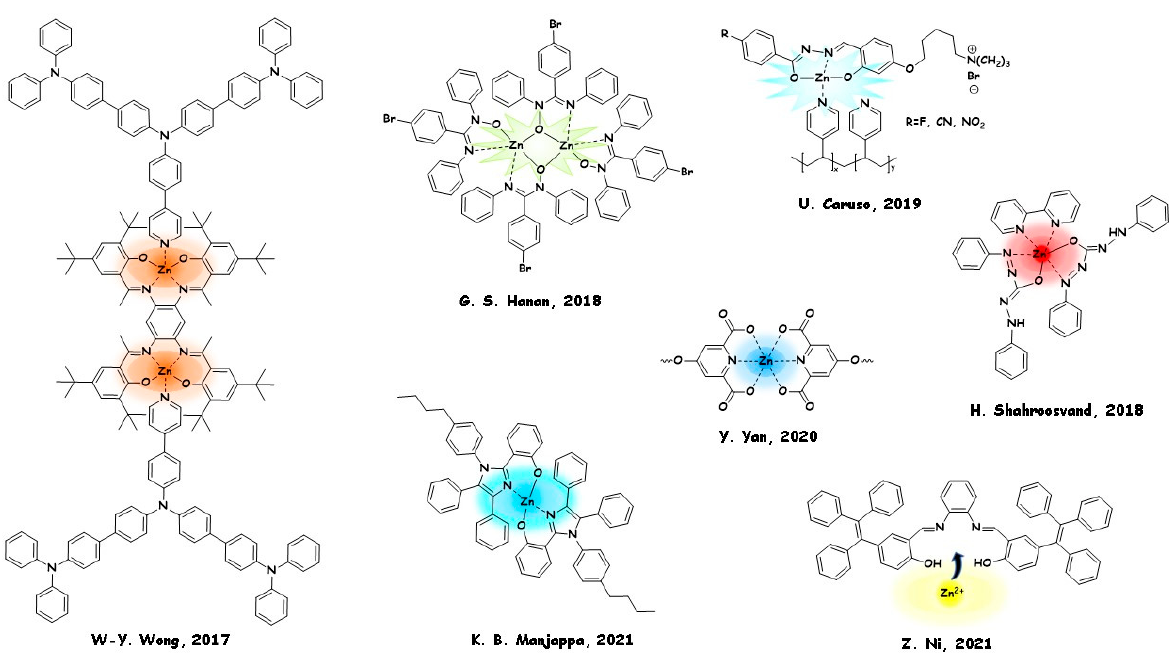
Figure 3. Zn AIEgens for optical applications.